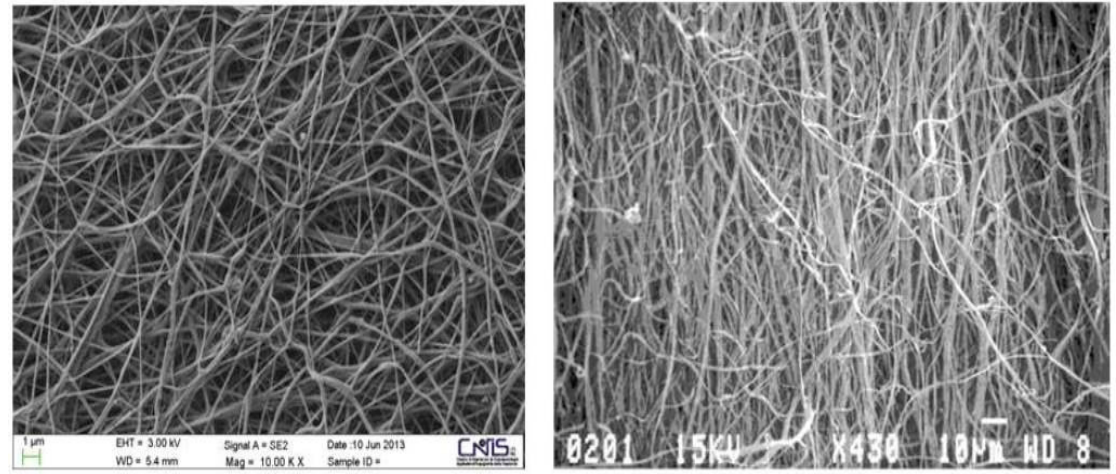
Figure 2. Porous structure of bio-composite Chitin Nanofibril scaffold (left) Extracellular Matrix (ECM)-like (right) at SEM microscopy. From: Morganti et al . J. of Clinical and Cosmetic Dermatology Vol.1:1, 2017; Open Access [22].